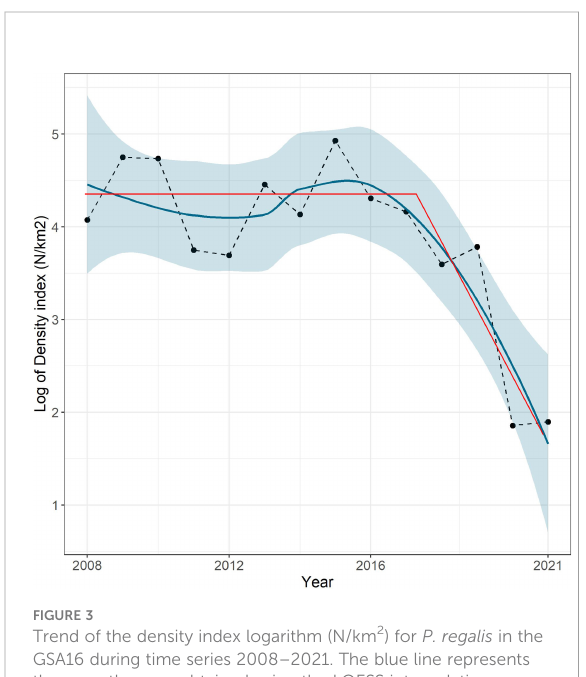
FIGURE 3 Trend of the density index logarithm (N/km 2 ) for P. regalis in the GSA16 during time series 2008 – 2021. The blue line represents the smooth curve obtained using the LOESS interpolation method; the blue area indicates the 95% con fi dence interval. The red lines visualize the segmented regression